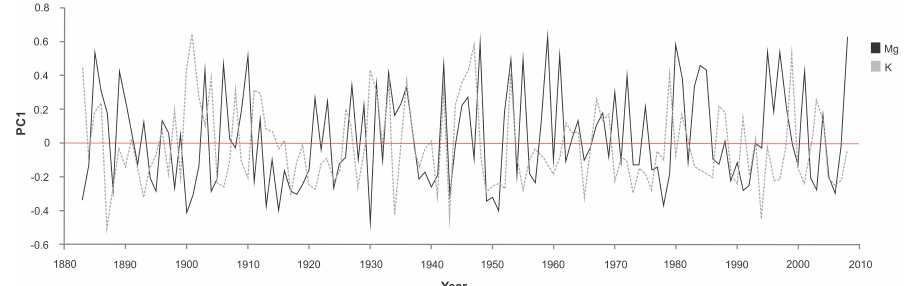
Figure 3. Variability of PC1 values in relation to age for magnesium (black) and potassium (gray). The red line marks the limit between positive and negative values.